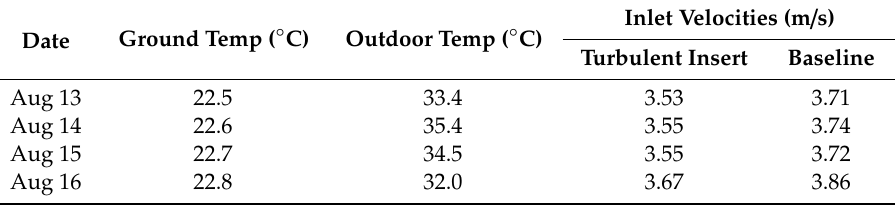
Table 1. Environmental conditions for the reported data.